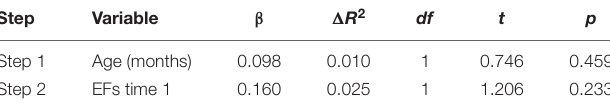
TABLE 7 | Stepwise regression for language